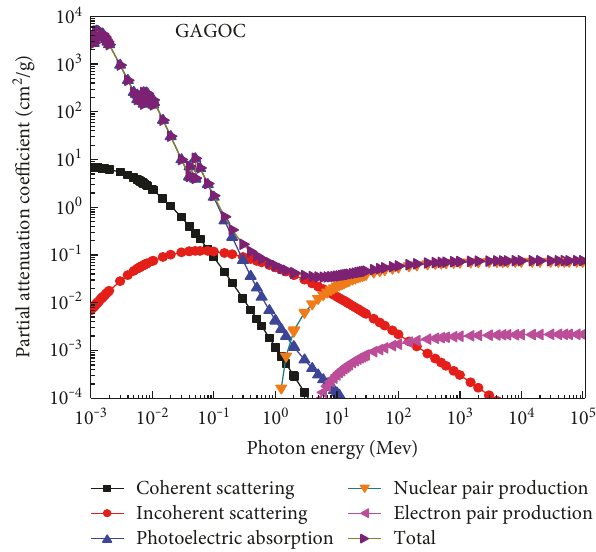
Figure 1: Variation of the total and partial mass attenuation coe ffi cient of GAGOC versus incident photon energy.